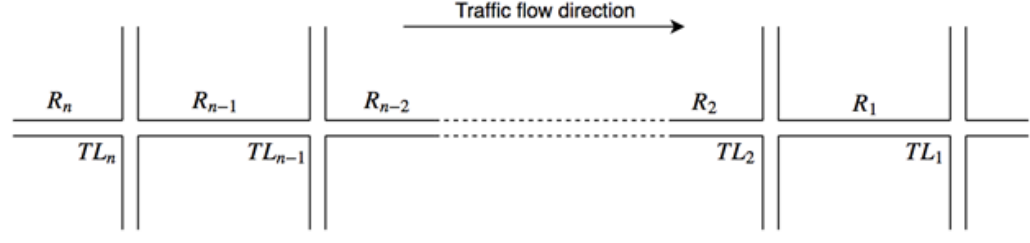
Figure 6. Adjacent junctions in a road